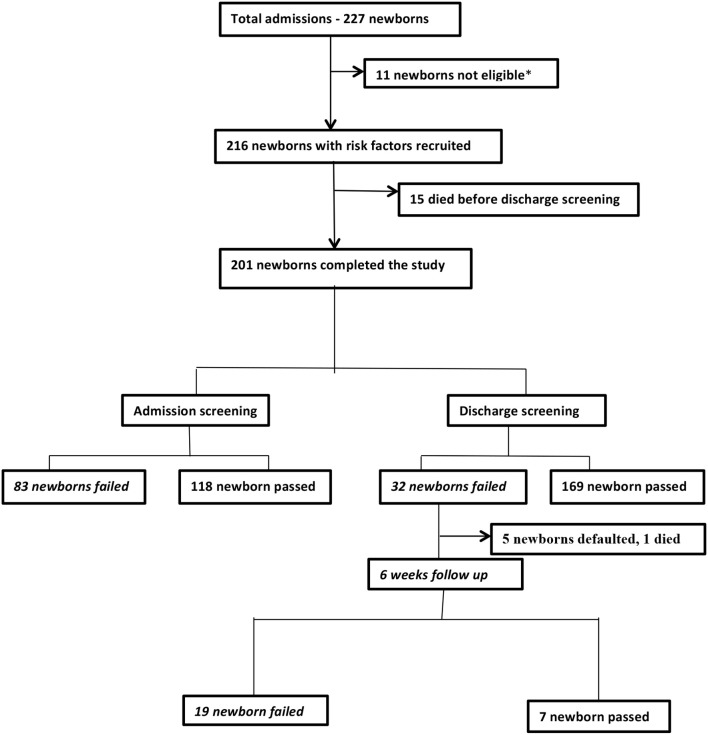
Parents of three newborns did not give consent, two newborns had no risk factors another one had maxillofacial malformation, while five newborns had been on multiple daily doses of intravenous aminoglycosides for more than 24 h prior to admission in our facility.